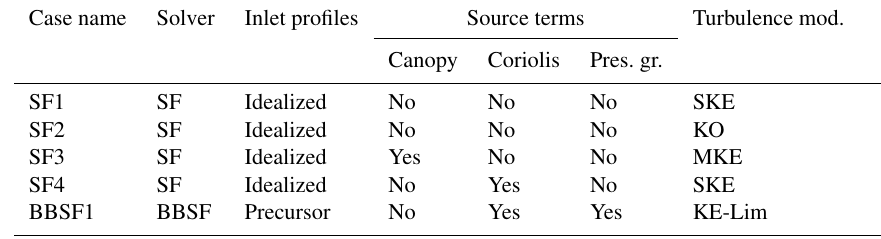
Table 2. List of simulation cases simulating a period of neutral atmosphere, 22:00–22:30 (4 May 2017).